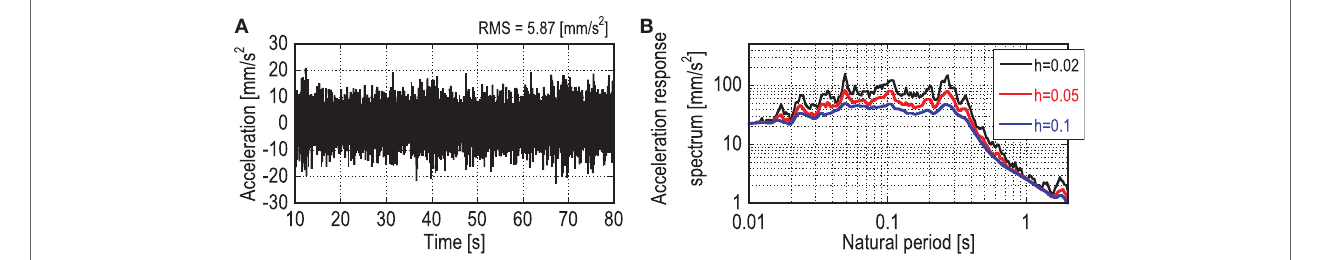
FIGURE 7 | Micro-tremor: (A) time history and (B) acceleration response spectrum.